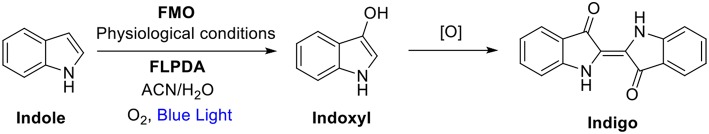
Indole oxidation to indoxyl and further oxidation and dimerization to indigo where FMO, Flavin-containing monooxygenases; FLPDA, flavin-polydopamine; CAN, acetonitrile; [O], further oxidation processes by O2 (Mermod et al., 1986; Meyer et al., 2002).